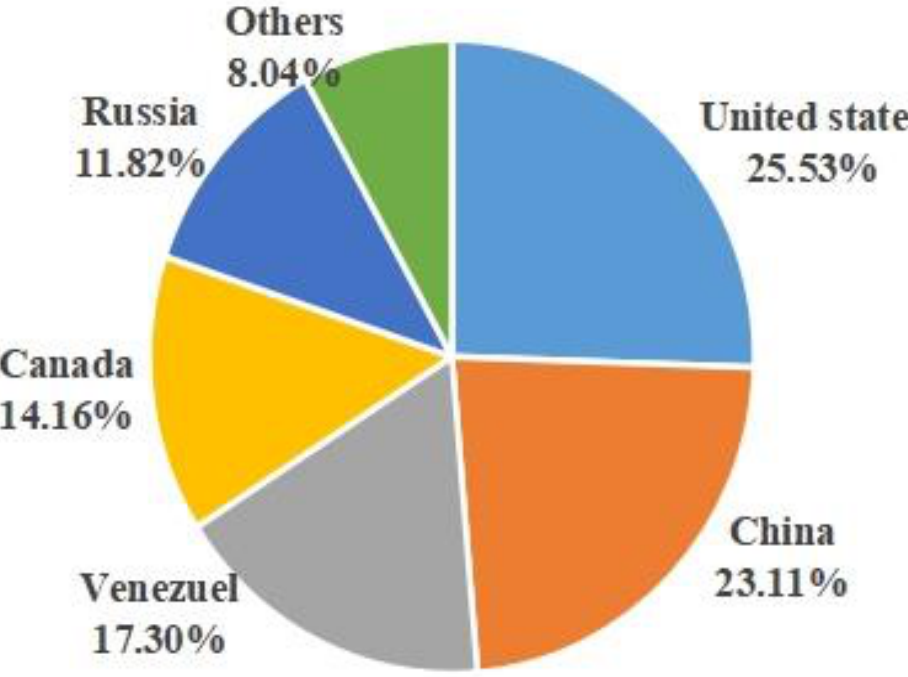
Figure 1. Production composition of tertiary recovery technologies for countries around the world (2012) .